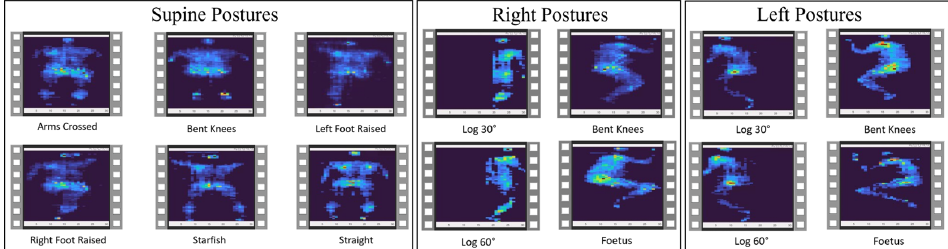
Figure 1. Sample images of the different postures for supine, right ‐ side, and left ‐ side positions.